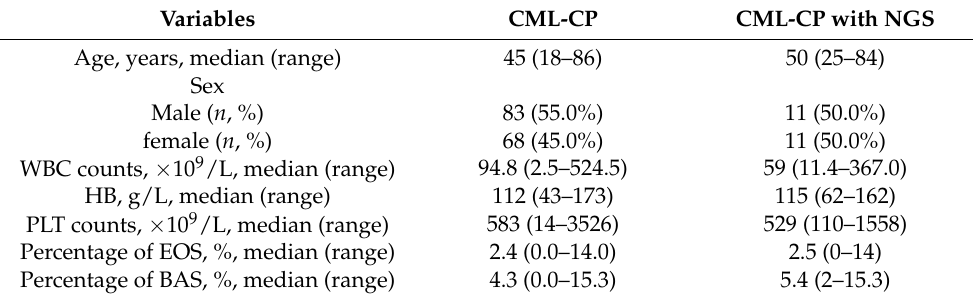
Table 1. Baseline characteristics of CML-CP patients and CML-CP patients performed by NGS. Variables